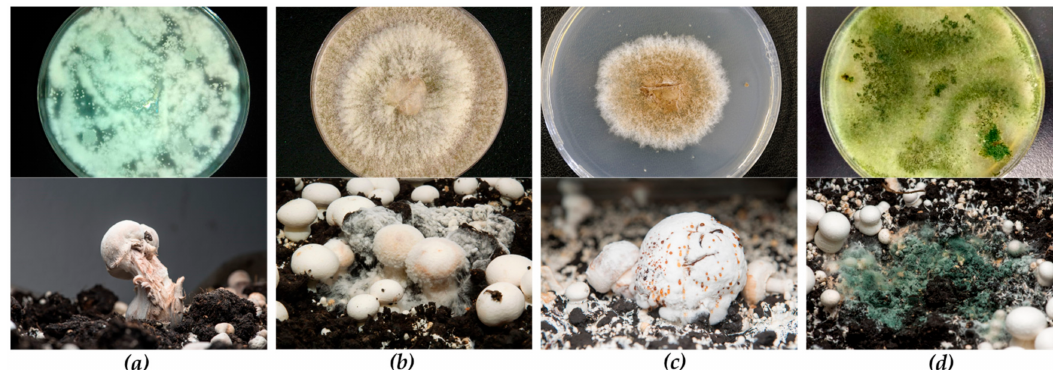
Figure 1. Mycoparasite plated on potato dextrose agar (PDA) (top pictures) and disease symptoms in Agaricus bisporus commercial crops (bottom pictures): ( a ) Lecanicillium fungicola /dry bubble disease (DBD); ( b ) Cladobotryum spp./cobweb disease; ( c ) Mycogone perniciosa /wet bubble disease (WBD); ( d ) Trichoderma spp./green mold